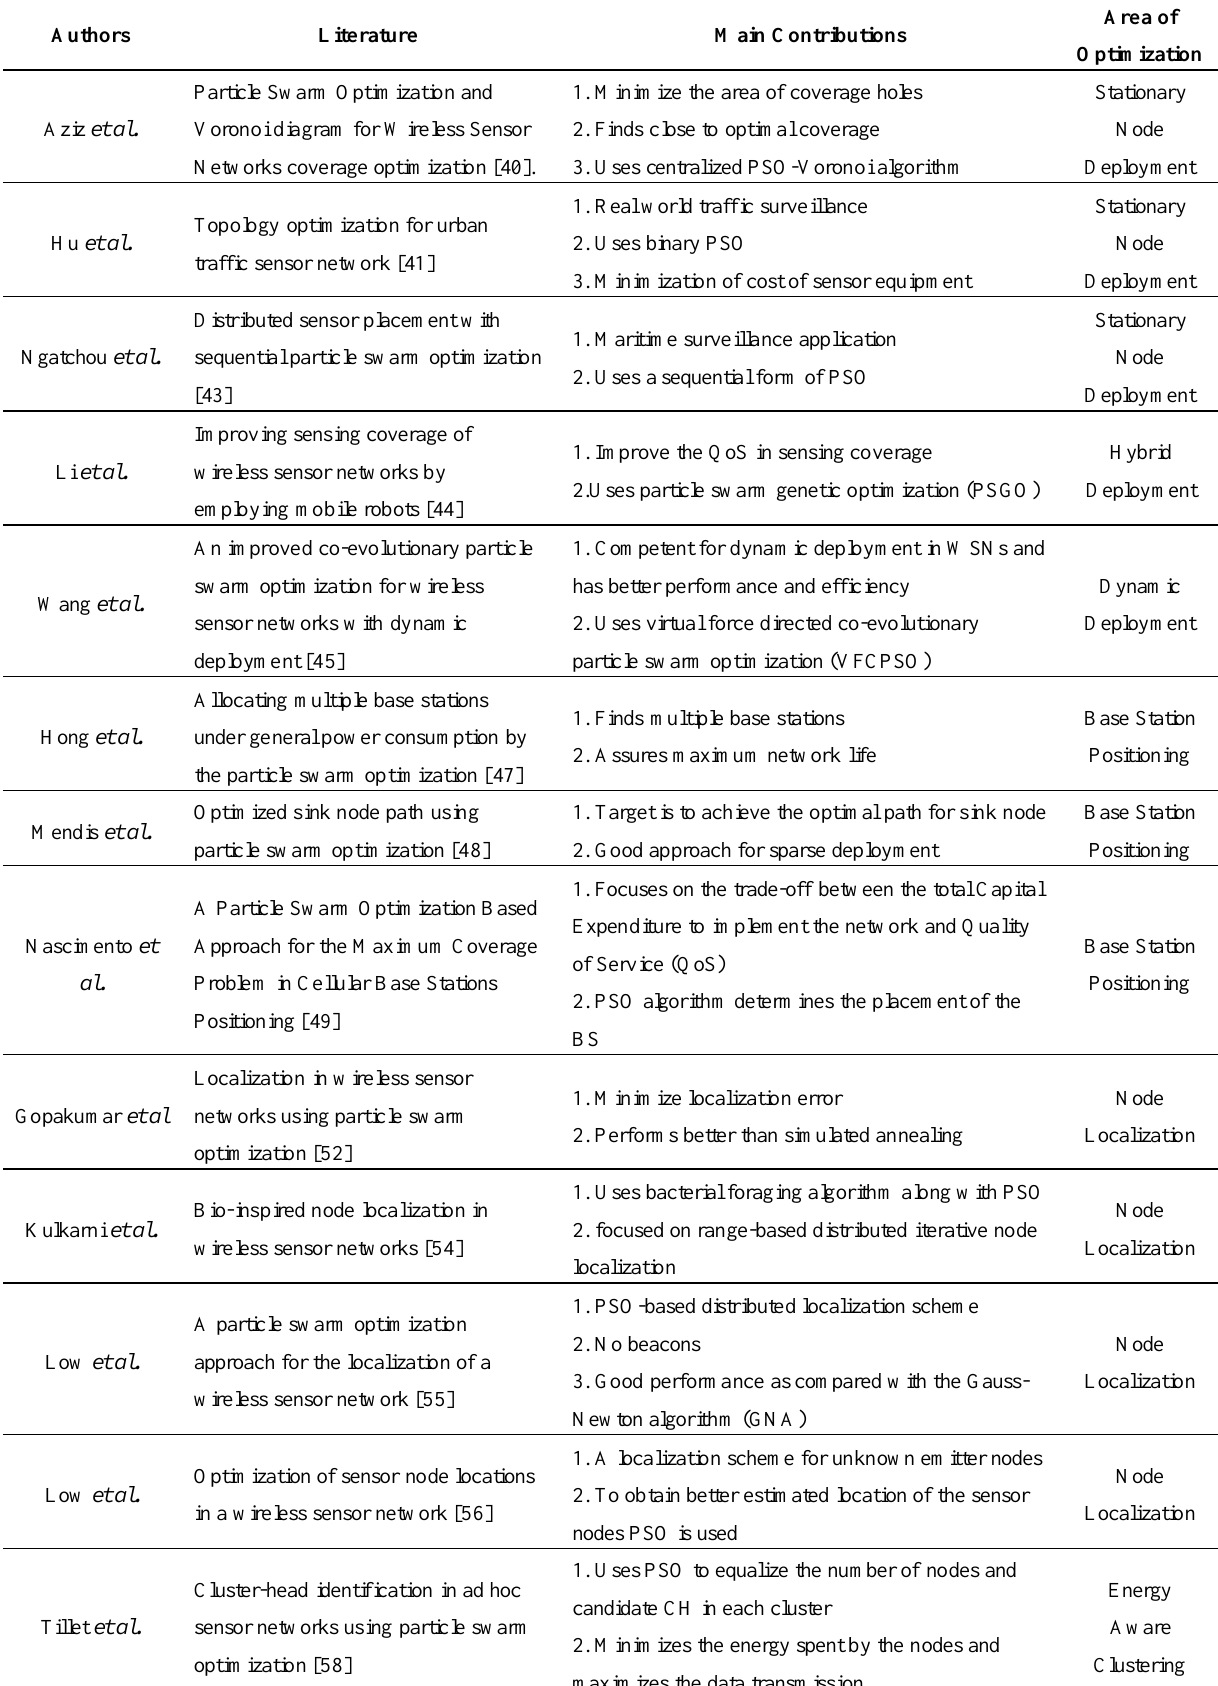
Table 2. Summary of PSO approaches in